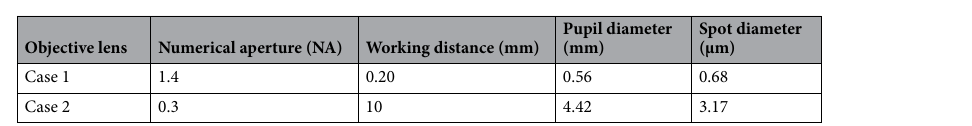
Table 1. Objective lens parameters with various NAs 32